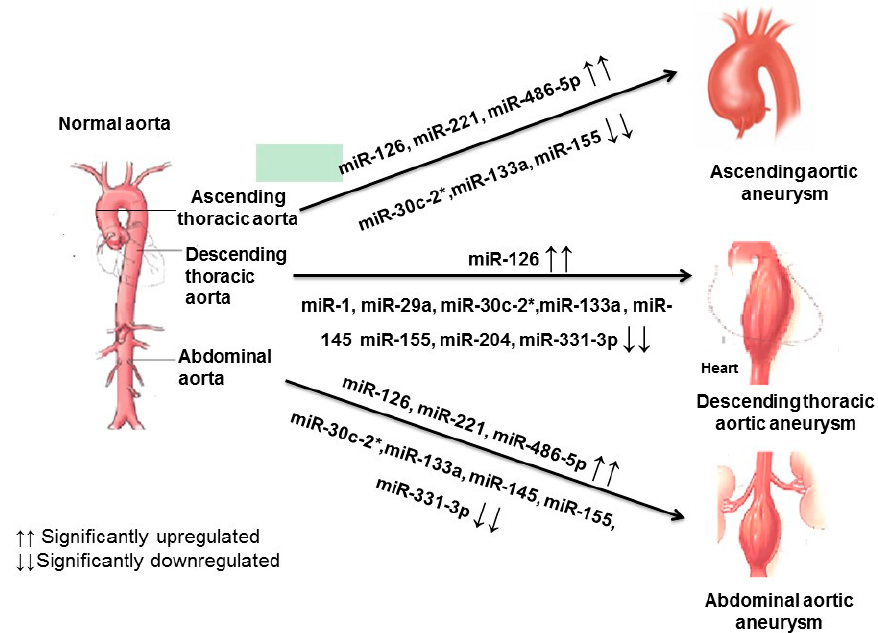
Figure 6. Dominant cardiovascular miRNAs patterns observed in TAA and AAA.